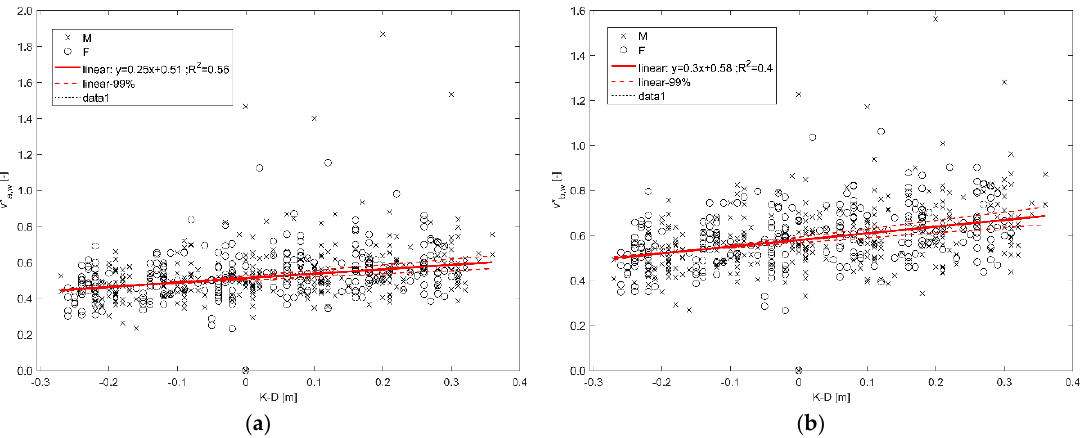
Figure 10. Normalized speed variation for walking conditions depending on K-D in respect to dry surface motion conditions, for the whole sample (male and female together): ( a ) according to the curve a [46]; ( b ) according to the curve b [43]. Linear regressions (dashed lines refer to expected values outside of the tested D range) and boundary conditions (99%) are shown. Male and female samples experimental pairs are shown.